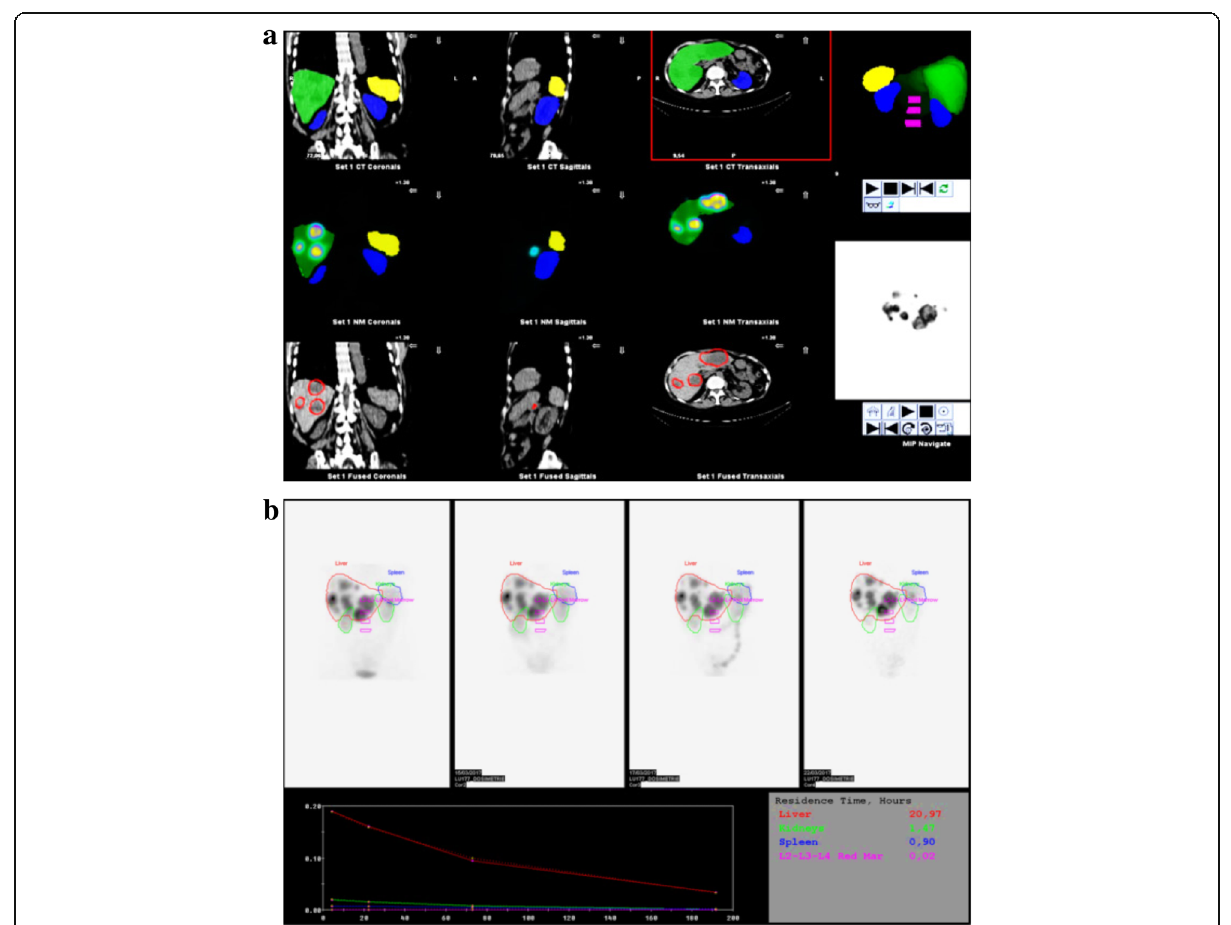
Fig. 3 Dosimetry toolkit® workflow. a Example of segmentation of the organs at risk performed manually using the Dosimetry Toolkit® tools using SPECT or CT data. b Segmentation propagation, time activity curves and residence times for all the regions of interest at 4 h, 24 h, 72 h and 192 h after drug